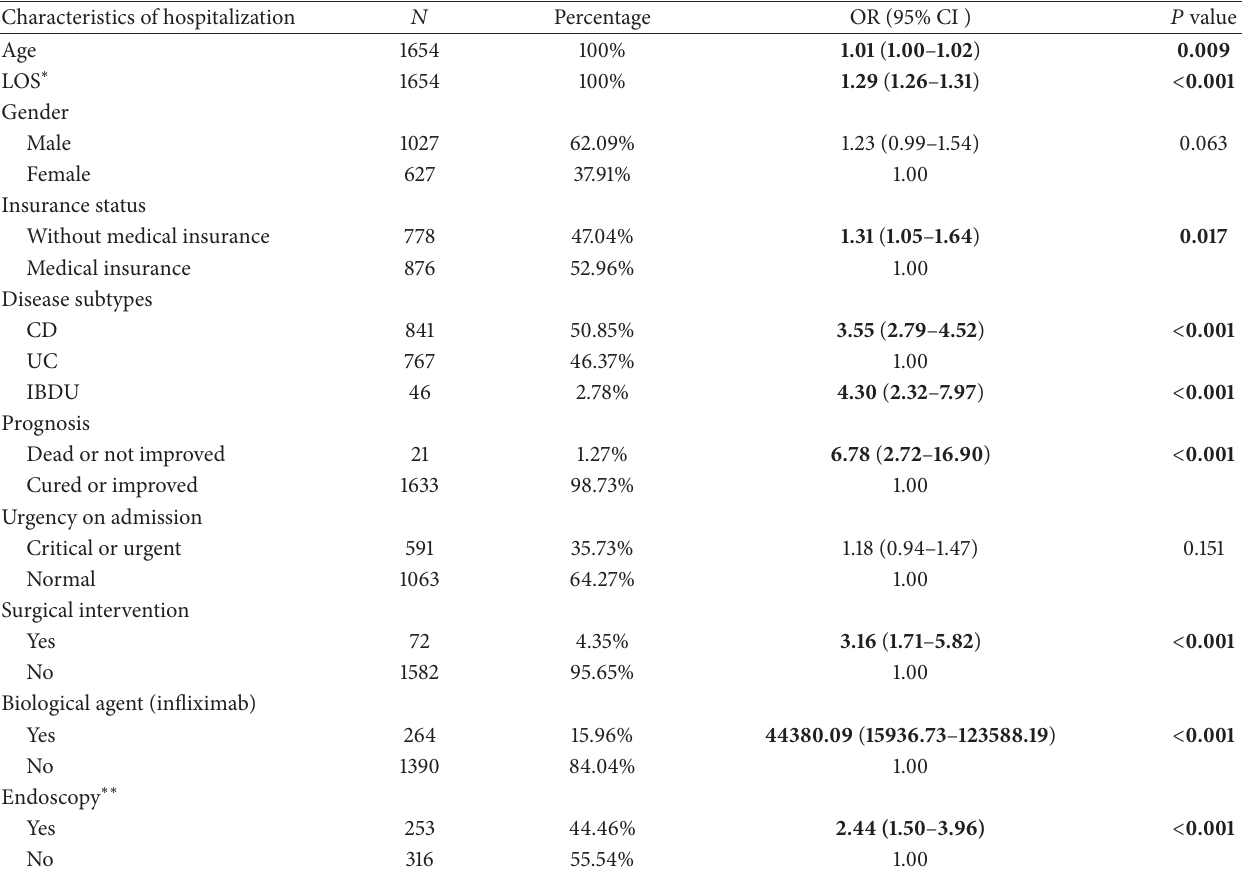
Table 1: Factors associated with hospitalization cost